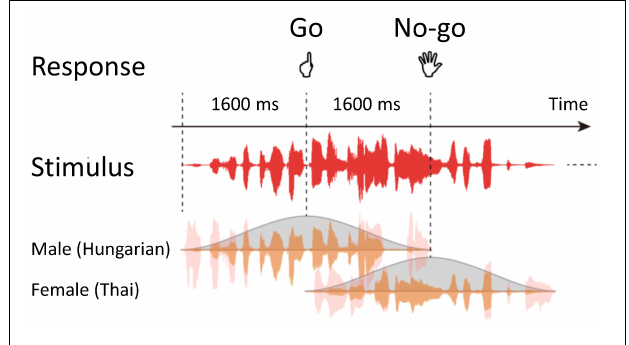
FIGURE 1 | Schematic representation of the auditory gradual-onset, continuous performance task (gradCPT). Stimuli temporally overlapped. Participants judged the genders of voices for each